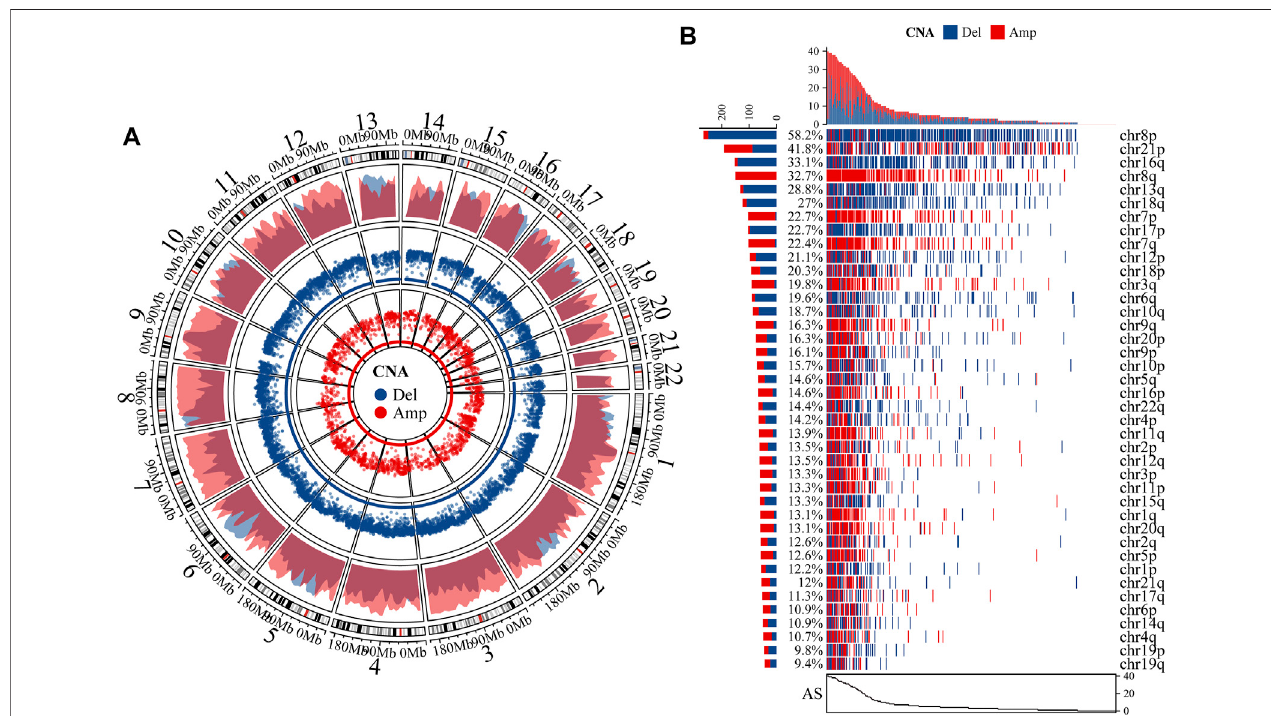
FIGURE 2 | Characteristics of aneuploidy. (A) We produced segmented CNA pro fi le by comparing absolute copy numbers with sample ploidy. Outermost ring is autosome ideogram; next is density plot of ampli fi ed (Amp) and deleted (Del) CNA whose y -axis represents density of regions with CNA. Two innermost rings represent rainfall plot whose y -axis stands for log10 (minimal distance of region). Radius of ring represents y -axis. (B) Waterfall plot of chromosome-arm-level CNA was estimated by comparing weighted copy number with sample ploidy across each chromosome arm.